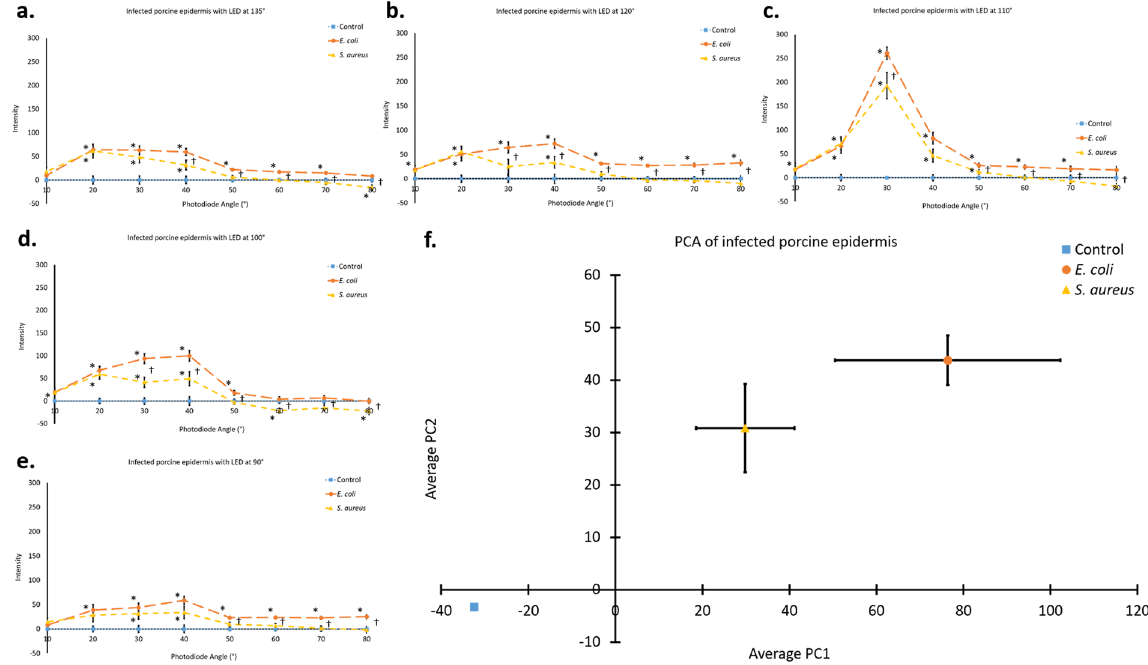
Figure 6. Identification of bacteria on a porcine epidermis model. ( a – e ) Data obtained from the photodiode array designed by scanning porcine epidermis samples inoculated with sterile LB, E. coli , or S. aureus . Incident light angle was changed for each of the five data sets; 135° ( a ), 120° ( b ), 110° ( c ), 100° ( d ), and 90° ( e ). At each individual incident light angle, significant differences result between bacterial inoculation and control samples as well as between each species of inoculation; E. coli or S. aureus . As expected, the trend changes as the incident light angle changes, but distinct differences are maintained despite changing trends with changing incident angles. One data point is considered to be the average of 12 readings from each photodiode (3 s scan). ( f ) Principle component analysis (PCA) of the data shown in ( a – e ) shows distinct differences between infections of the porcine epidermis with E. coli vs. S. aureus vs. only the commensal bacteria present on control samples. The two principle components shown, PC1 and PC2, account for 92% of the data shown in ( a – e ), 79% and 13% for PC1 and PC2, respectively. Each of five porcine epidermis samples was scanned at three unique locations for 3 s at each location. Error bars represent standard error of the mean, the control group in ( f ) has standard error of zero. * is shown to the left side of each data point indicating significant difference (p < 0.05) between E. coli vs. control samples or between S. aureus vs. control samples. † is shown to the right side of each data point indicating significant difference (p < 0.05) between E. coli vs. S. aureus